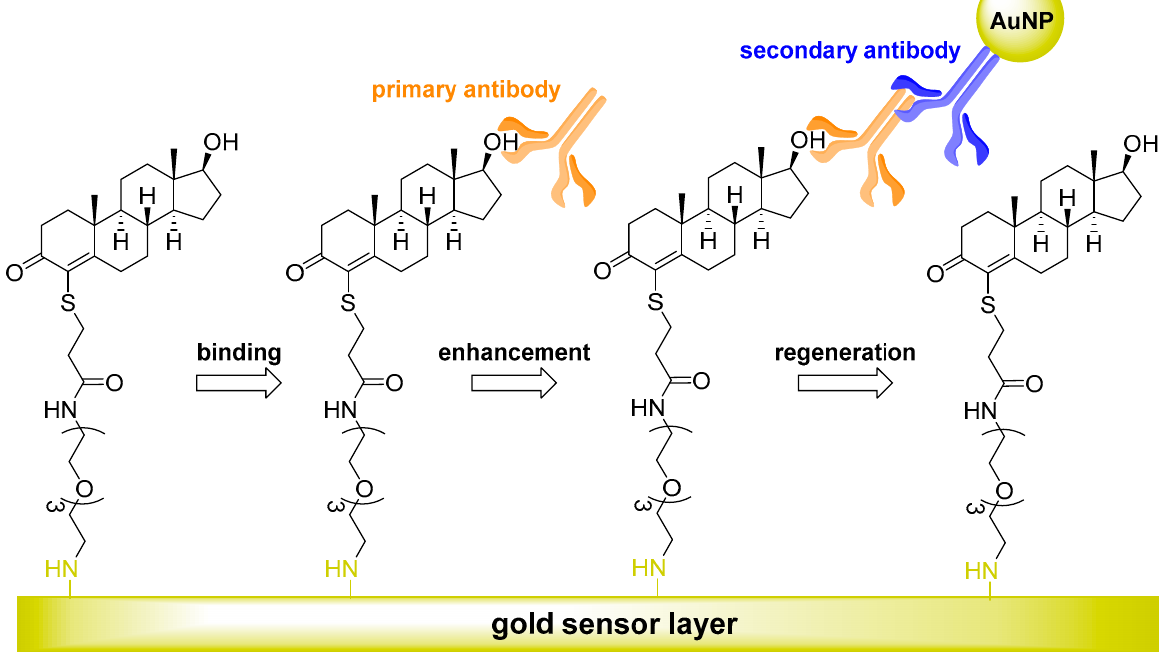
Figure 3. A diagram depicting the principle of a binding process in a surface plasmon resonance (SPR) immunosensor assay with nanogold labeling. An amino-terminated oligo(ethylene glycol)-linked testosterone conjugate was synthesized and immobilized on an SPR biosensor. The immunosensor system for testosterone utilized both secondary antibody and gold nanoparticle (AuNP) signal enhancement. The mechanism for the increased sensitivity resulted from increased binding mass and an Au–plasmon coupling effect. The addition of a secondary antibody with an attached AuNP increased the signal sensitivity of the assay by 12.5-fold compared to the primary antibody alone. The biosensor was stable for more than 330 binding and regeneration cycles [107].